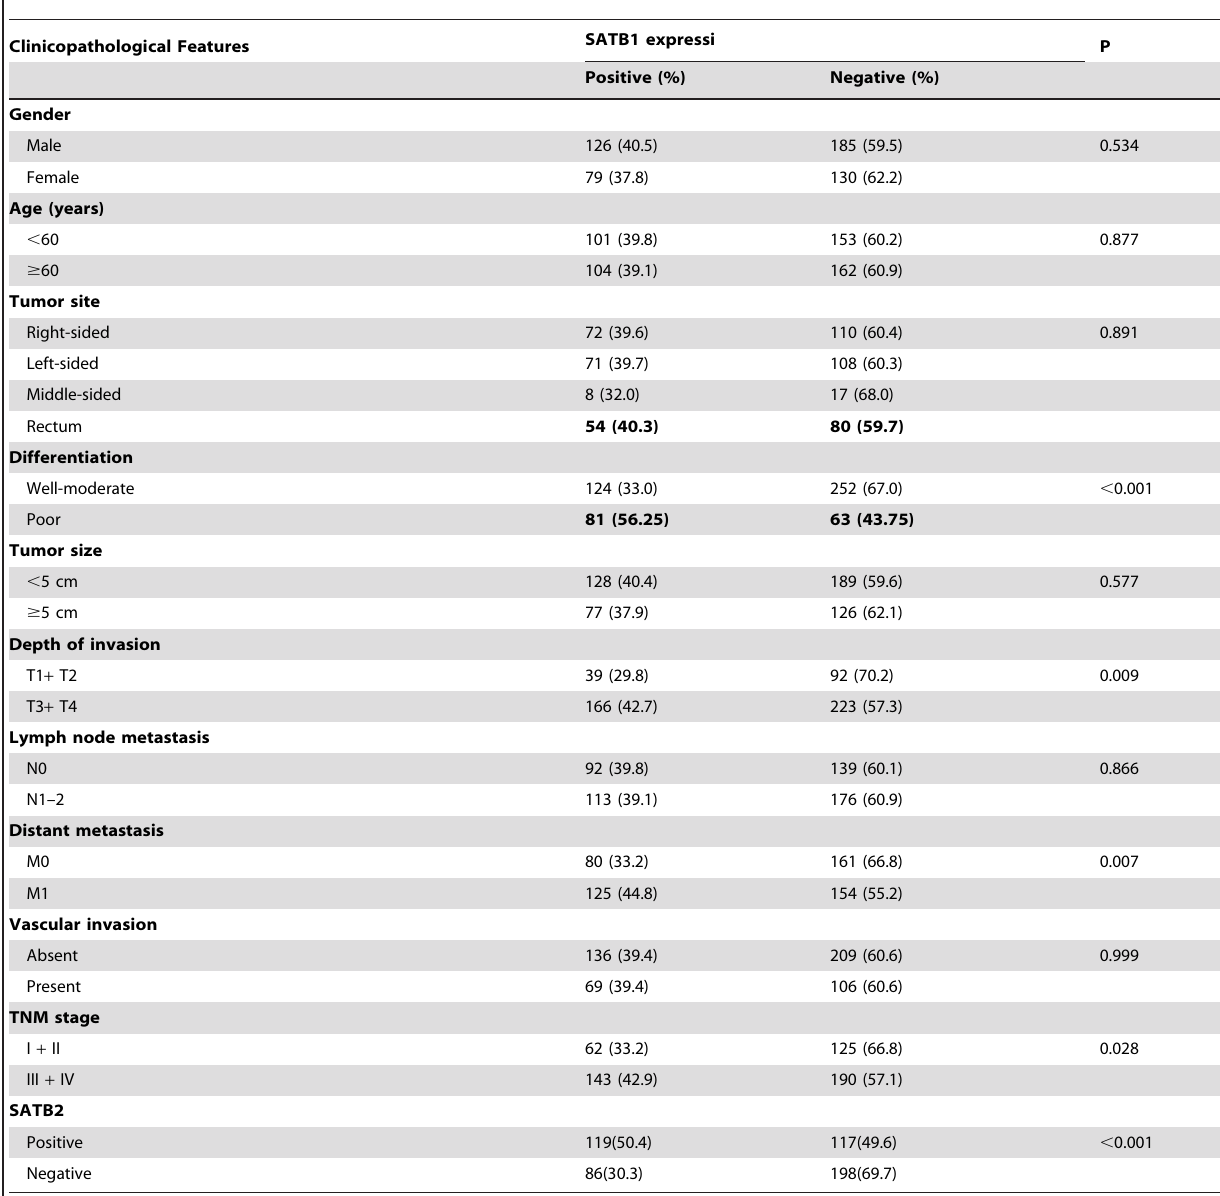
Table 2. Association of SATB1 expression with clinicopathological features and SATB2 (n=520).